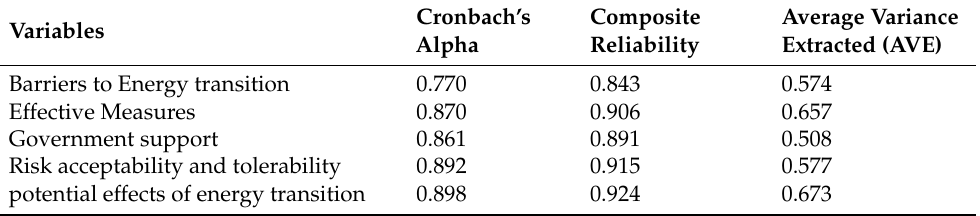
Table 2. Reliability analysis.